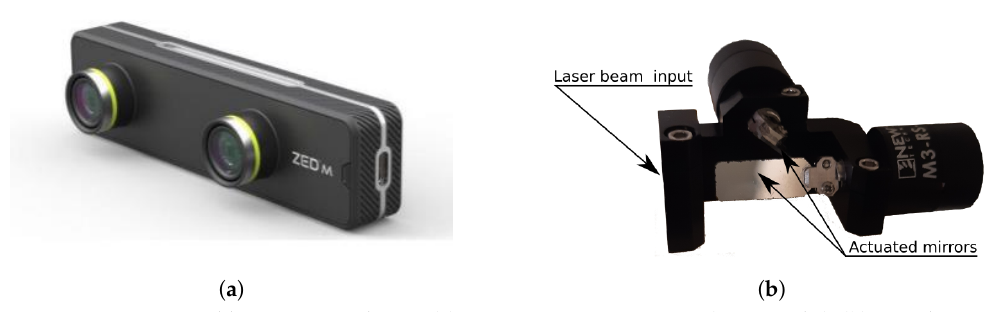
Figure 3. Camera and laser steering device. ( a ) ZED mini RGB-D camera (Stereo Labs); ( b ) Two degrees of freedom actuated mirrors for laser positioning (DK-M3-RS-U-2M-20-L, Newscale Technology).